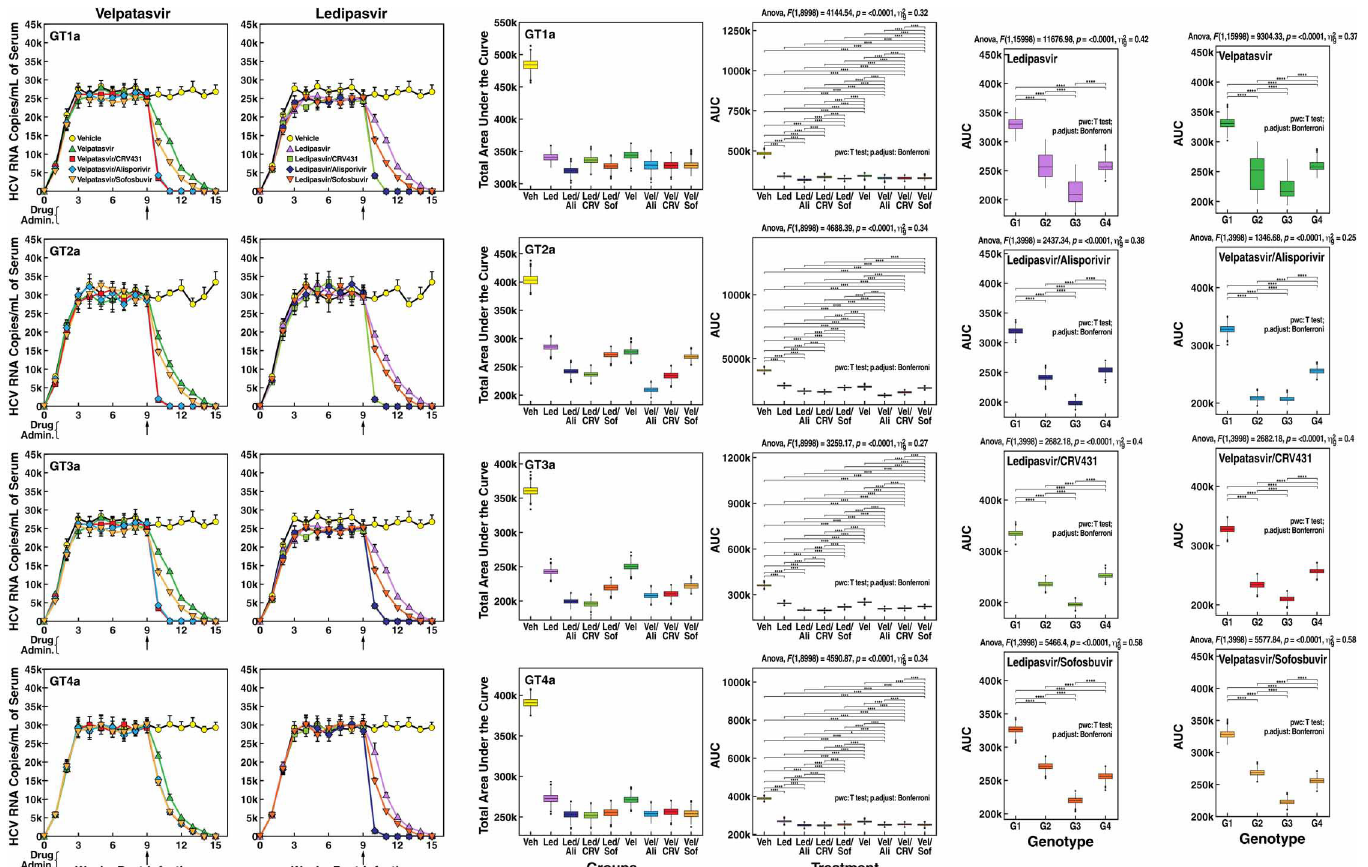
Fig 3. Combinational analysis of anti-HCV efficacy of Velpatasvir, Ledipasvir, Alisporivir and CRV431 in humanized-liver chimeric mice. A. MUP- uPA-SCID-Beige mice implanted with human hepatocytes were infected i.v. with plasma from HCV-infected chimpanzee (100 infectious doses (CID 50 )/mL of GT1a, GT2a, GT3a and GT4a). Drugs were orally given alone (50 mg/kg) or in combination (50/50 mg/kg) 9 weeks post-infection. Blood was collected until week 15 post-HCV infection. Ten mice per treatment. Viral replication (HCV RNA copies/ml of serum) was quantified by real-time reverse transcription PCR. Error bars corresponds to the SD between 10 animals. At week 12 and 15 post-infection, SD are small due to the minimal viral loads due to the drug treatment efficacy. B. Statistical analyses for drug combination effect between HCV genotypes. C. Statistical analyses for Ledipasvir combination effect on HCV GT1a, GT2a, GT3a and GT4a. D. Statistical analyses for Velpatasvir combination effect on HCV GT1a, GT2a, GT3a and GT4a. For each treatment/genotype combination, we simulated 1,000 draws using the mean and standard deviation from the experimental results to account for the uncertainty in estimating the Area Under the Curve for the level of viremia. Area Under the Curve was estimated using the trapezoidal method. Groups were compared using t-tests and the permutation test. P-values were adjusted for multiple comparisons using the Bonferroni correction. Data are representative of two independent